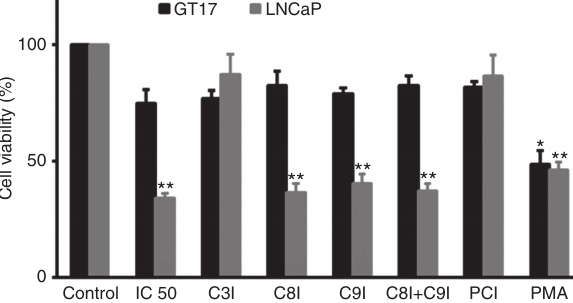
050 Figure 8 Effect of caspase inhibitors C3I, C8I, C9I, and PCI on the viability of GT1-7 neurons and LNCaP cells pretreated SPIONs@ Au-LHRH and then exposed to a magnetic field (465 Oe; 15 min). Both GT1-7 neurons and LNCaP cells after 1 h preincubation with caspase inhibitors (final concentration: 20 μ m) were exposed to 0, 100, or 250 μ g/ml SPIONs@Au-LHRH for 24 h. Following the in GT1-7 neurons and Figure 7 Changes in mitochondrial ΔΨ m LNCaP cells pretreated with 100 or 250 μ g/ml SPIONs@Au-LHRH